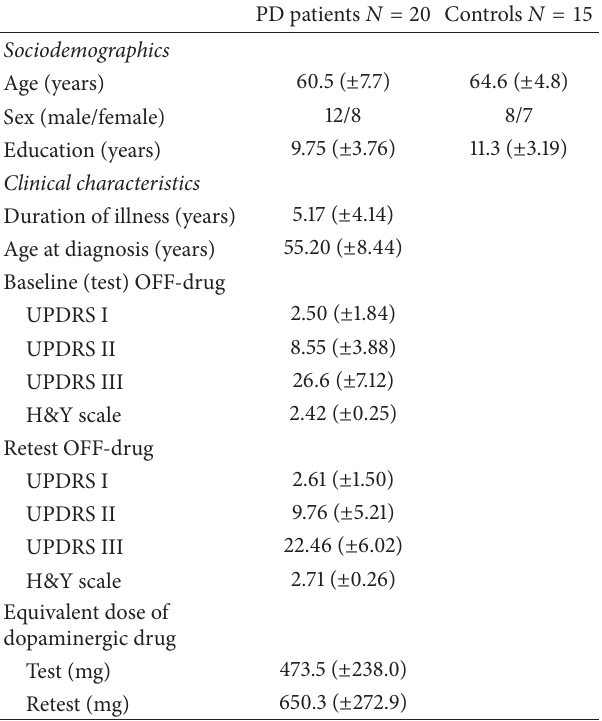
Table 1: Sociodemographic and clinical characteristics of the two study groups. Values denote mean ( ± standard deviation) or numbers of